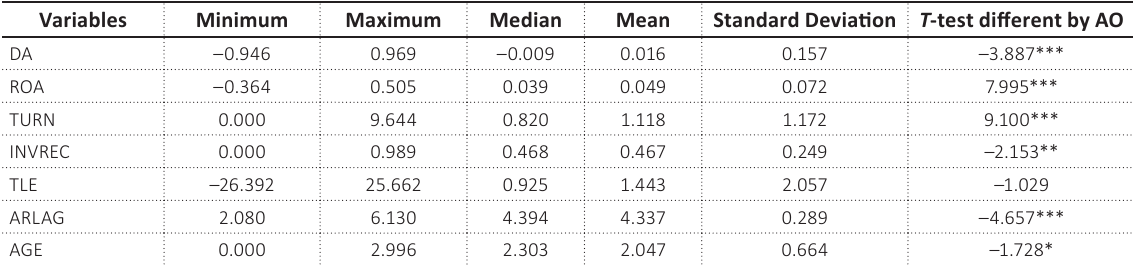
Table 1. Descriptive statistics for continuous variables